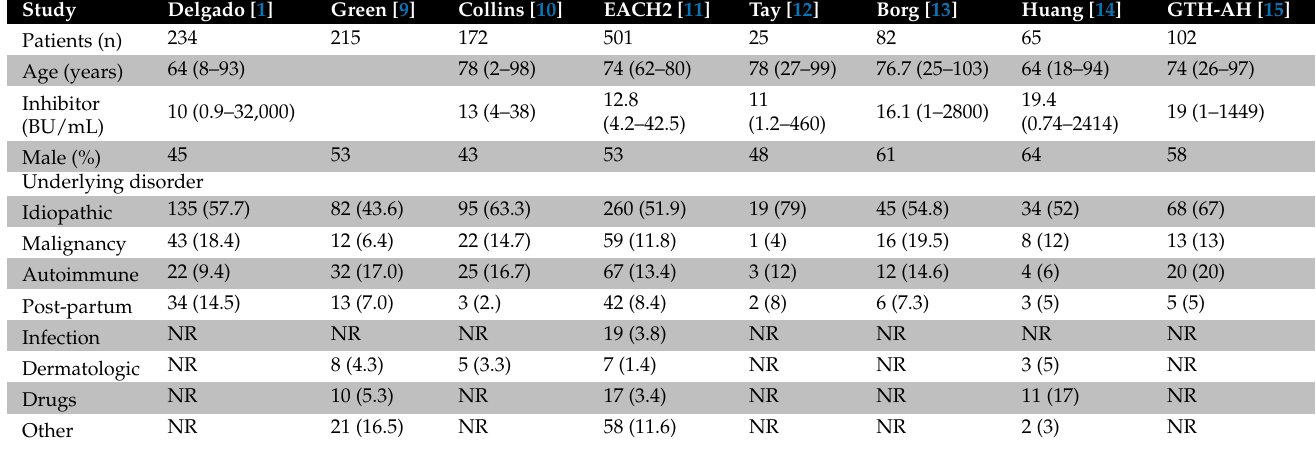
Table 1. Demographic and clinical characteristics of patients with acquired hemophilia A in